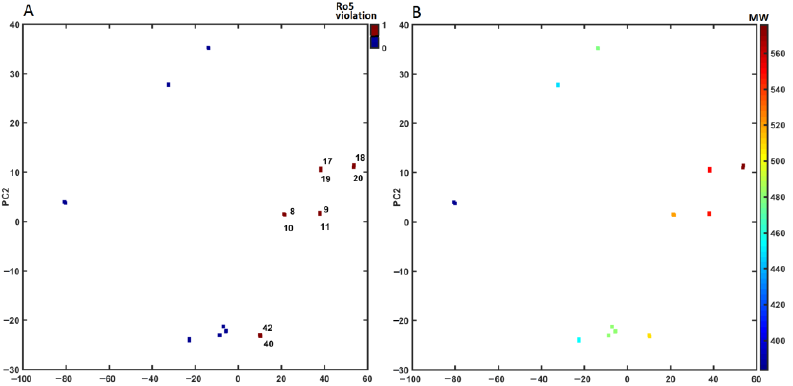
Figure 11. Projection of carborane-based derivatives on the plane defined by the first vs. second principal component for Dragon descriptors with violations of Ro5 ( A ) and calculated MW ( B ). Colors code the numerical values of Ro5 violations and MW.